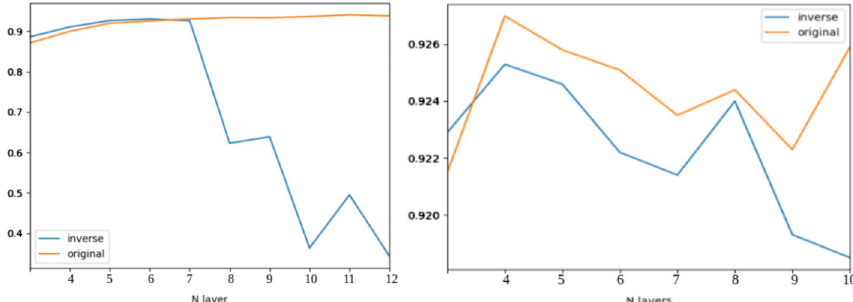
Fig. 12 Impact of the numerical errors on the accuracy of (left) layer-wise invertible models and (right) hybrid architecture model. (Left): evolution of the accuracy with depth for a negative slope n and without inverse reconstructions. Without reconstruction, the model accuracy benefits from depth. With inverse reconstructions, the model similarly benefits from depth as the number of layers grow from 3 to 7. For N > 7 , however, the accuracy sharply decreases toward lower values due to numerical errors. (Right): our proposed hybrid architecture greatly stabilizes the numerical errors, which results in smaller effects of the depth and negative slope on accuracy